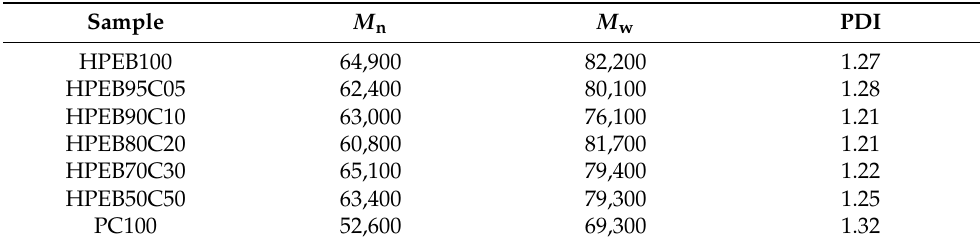
Table 2. Average molecular weight and distribution of the polyurethane